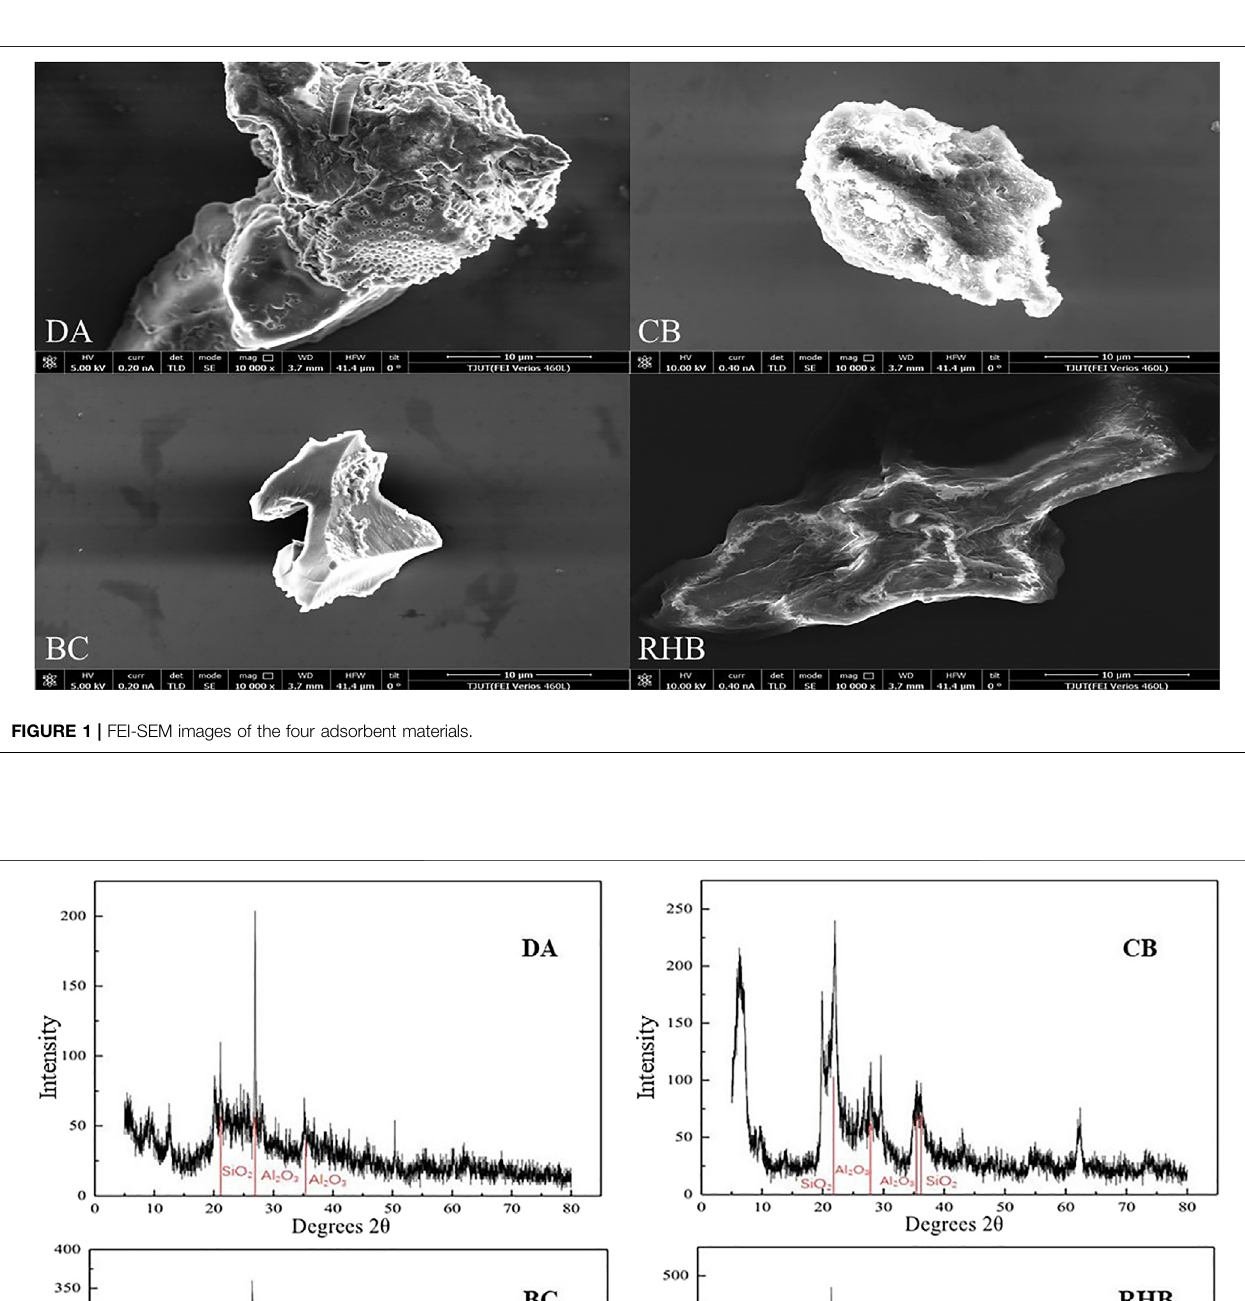
Frontiers in Chemistry |